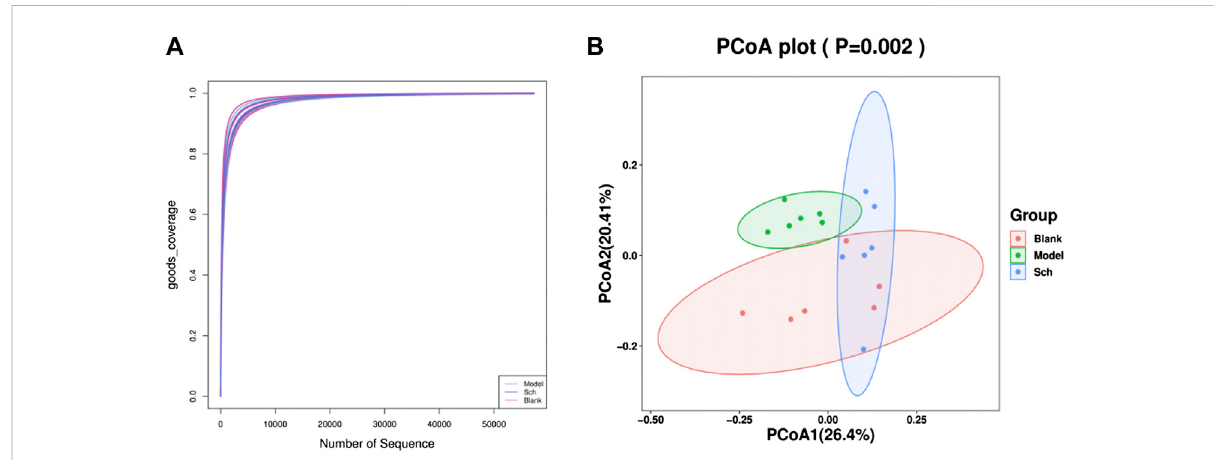
FIGURE 7 Diversity analysis of the GM. (A) Good ’ s coverage rarefaction curve of alpha diversity analysis; (B) PCoA analysis of beta diversity analysis.